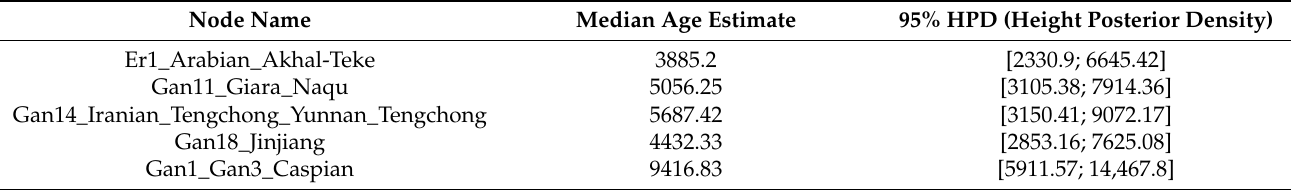
Table 2. BEAST age estimates of the relevant nodes with the ancient Mongolian horses studied in the phylogenetic tree constructed